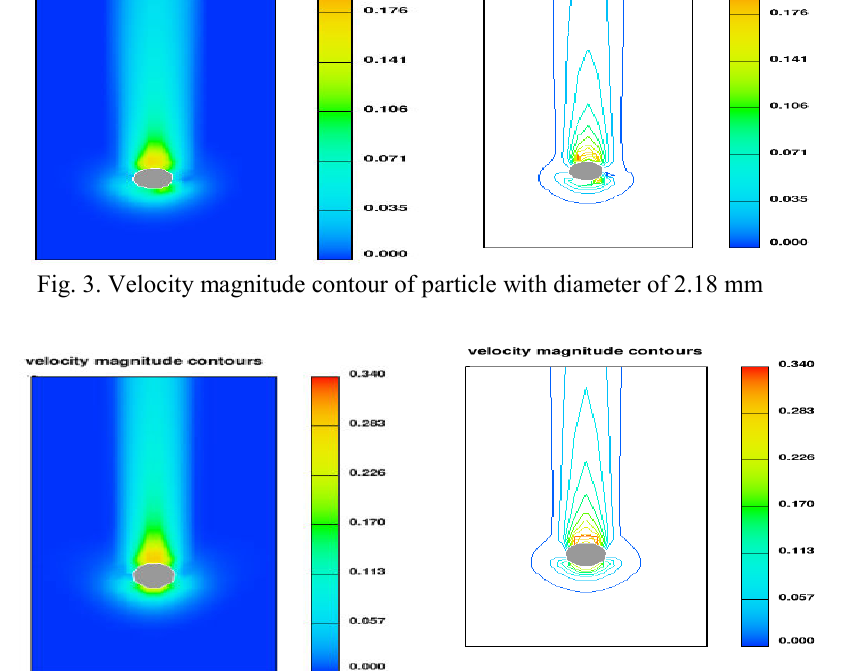
Fig. 4. Velocity magnitude contour of particle with diameter of 4.36 mm